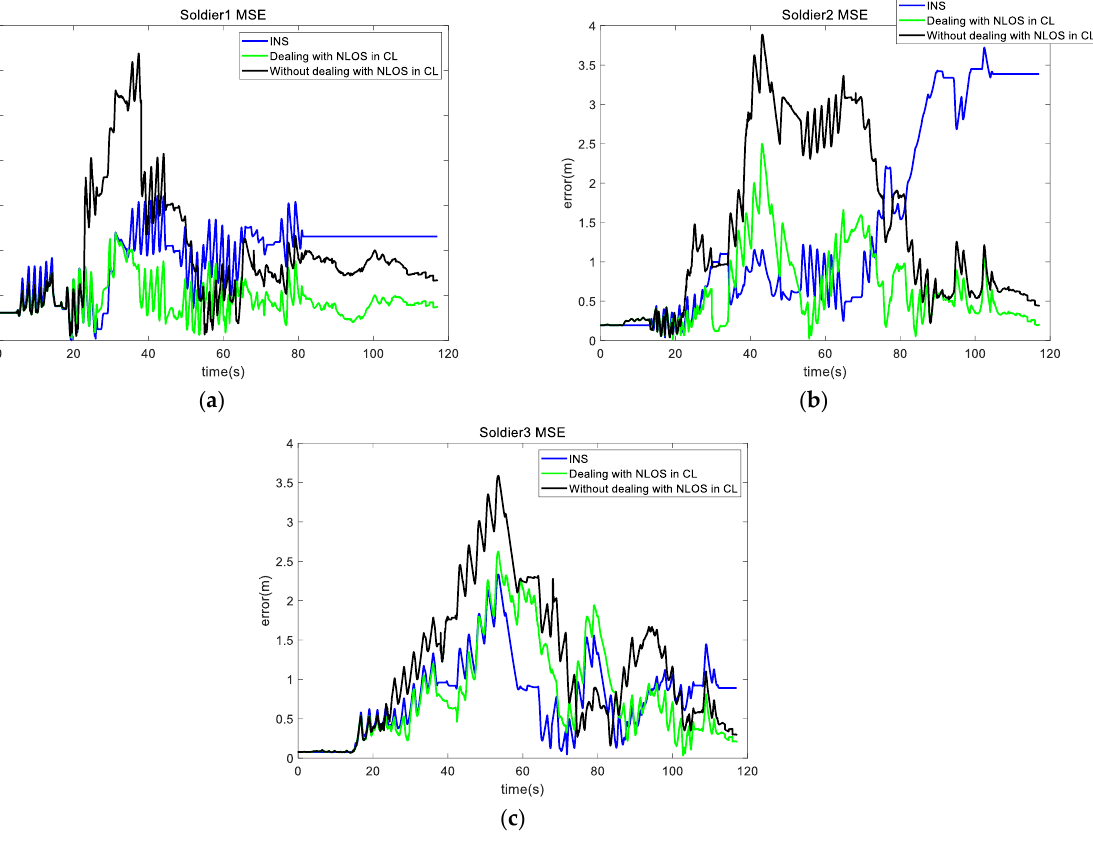
Figure 6. MSE of soldiers. ( a ) MSE of soldier 1; ( b ) MSE of soldier 2; ( c ) MSE of soldier 3.